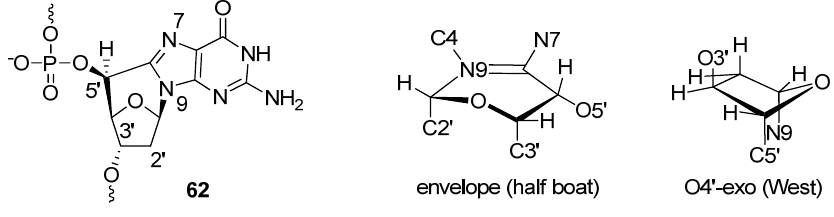
Figure 3. The structure of 5 ′ ,8-deoxyguanosine in